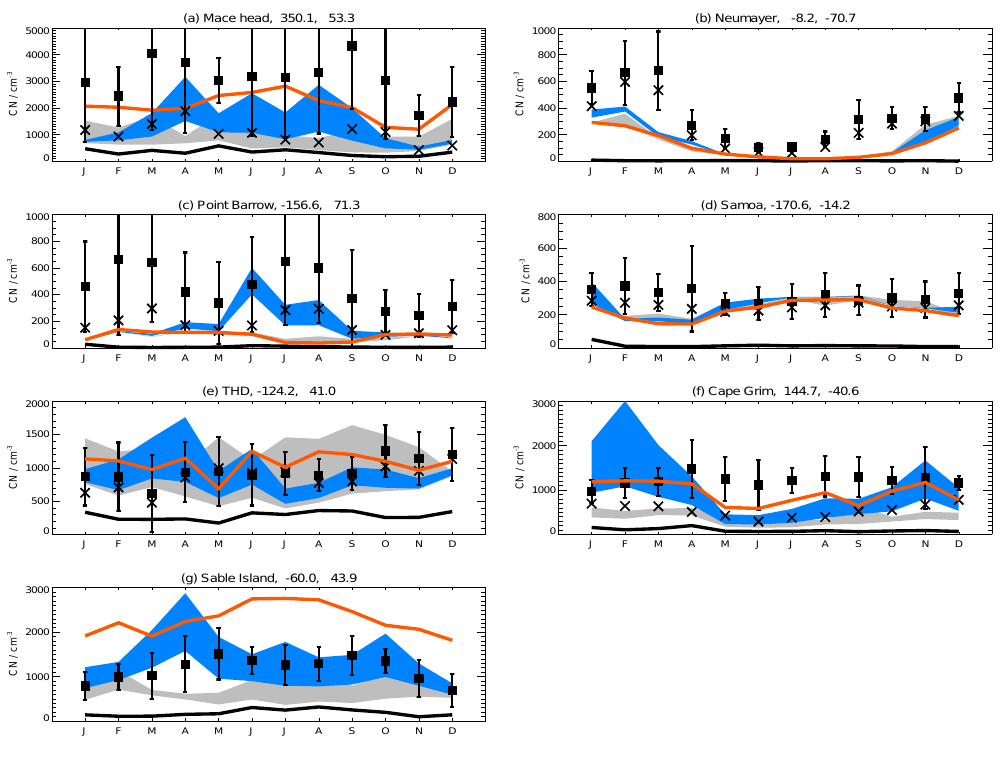
Fig. 5. As for Fig. 4 but for MBL